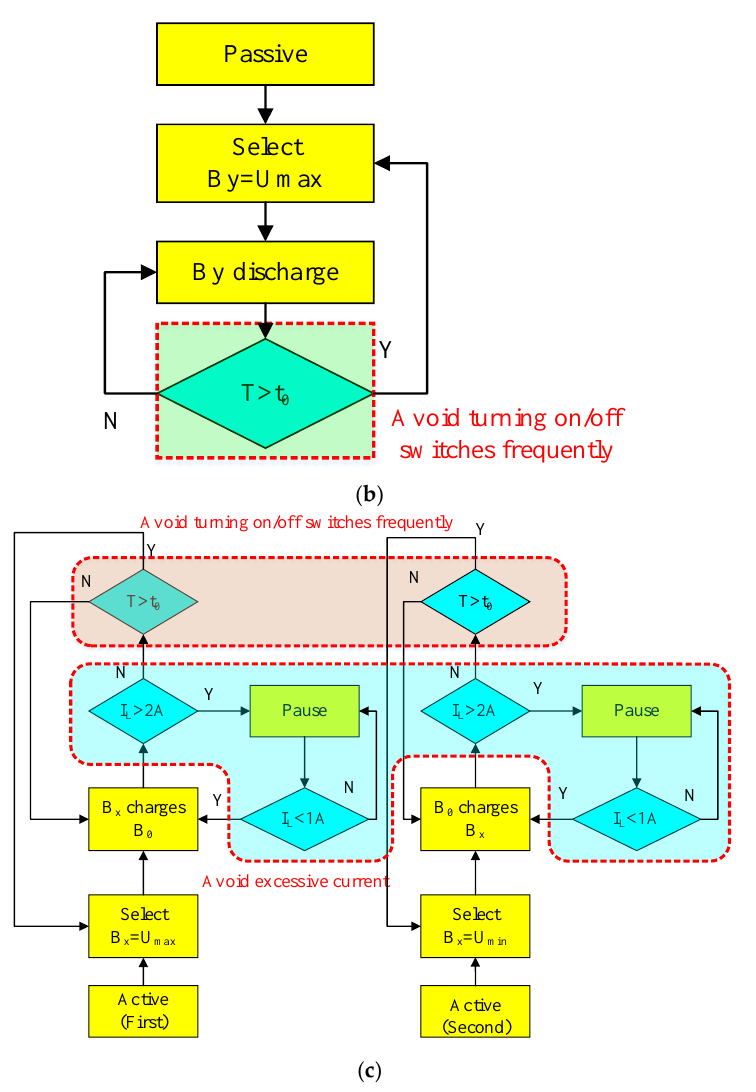
Figure 3. Flow chart of composite equalization control strategy. ( a ) Selection of composite equalization mode; ( b ) passive equalization mode; and ( c ) active equalization mode.